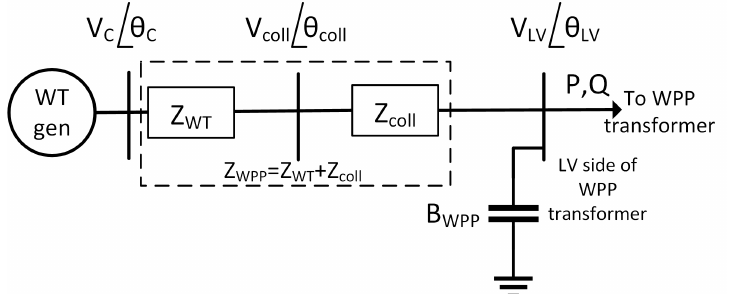
Figure 5. Reactive power capability model of WPP with aggregated WPP collection